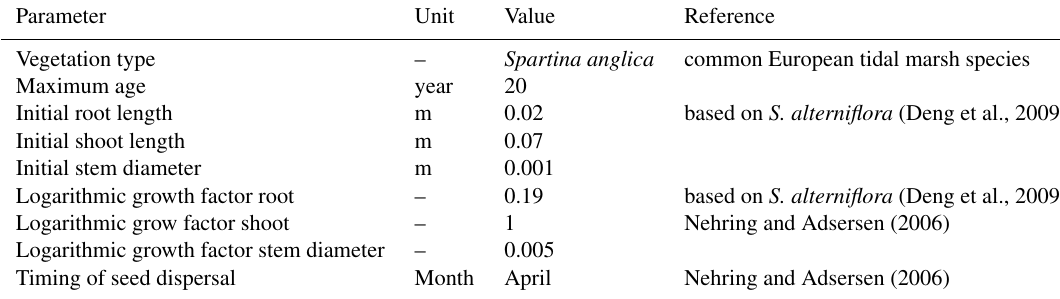
Table 2. Parameterisation of general characteristics of Spartina anglica